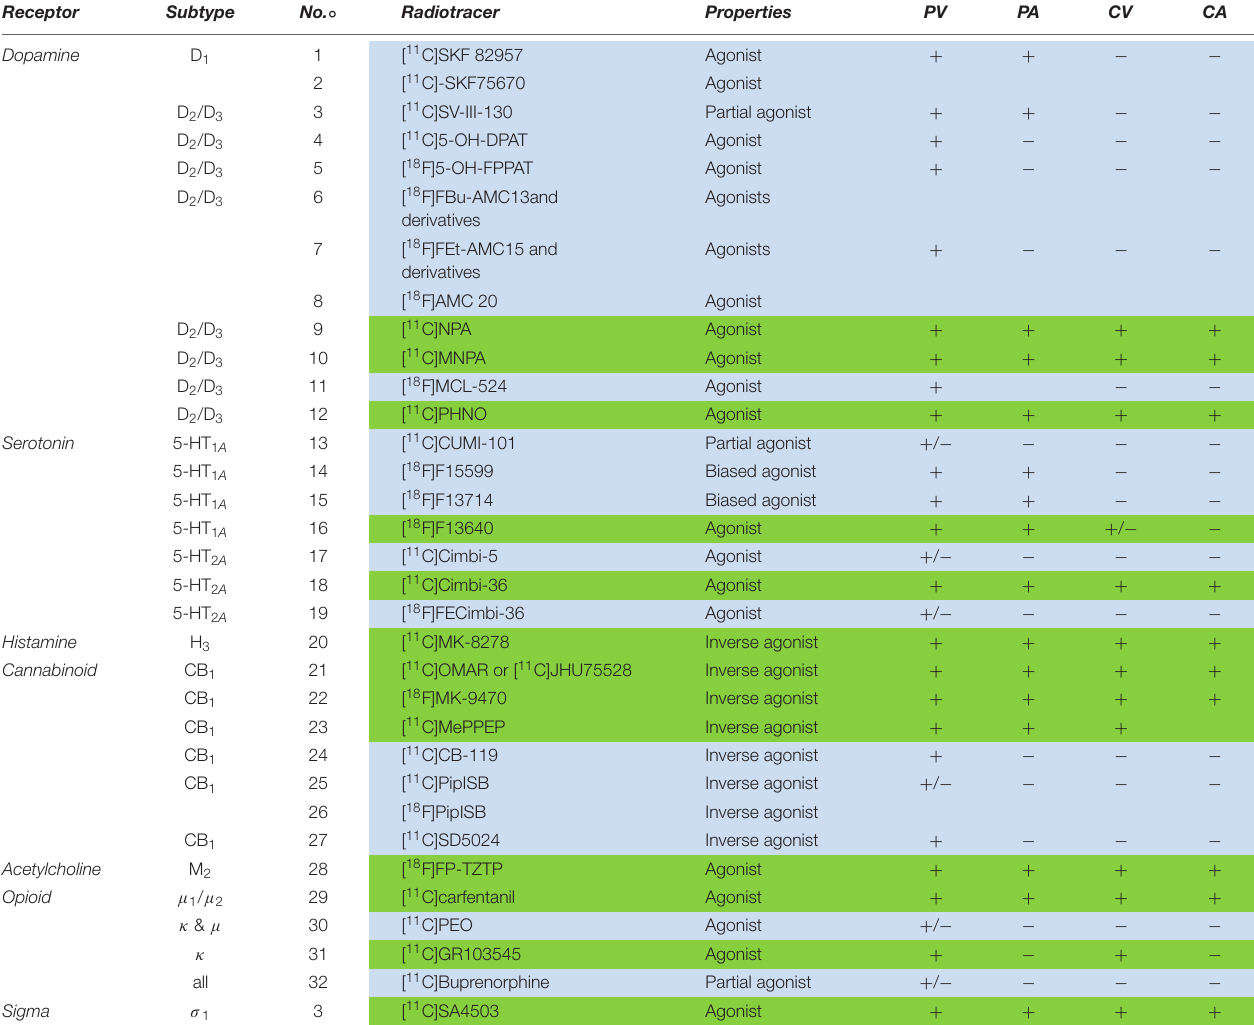
TABLE 1 | Current agonist radiotracers of GPCRs with at least preclinical validation.